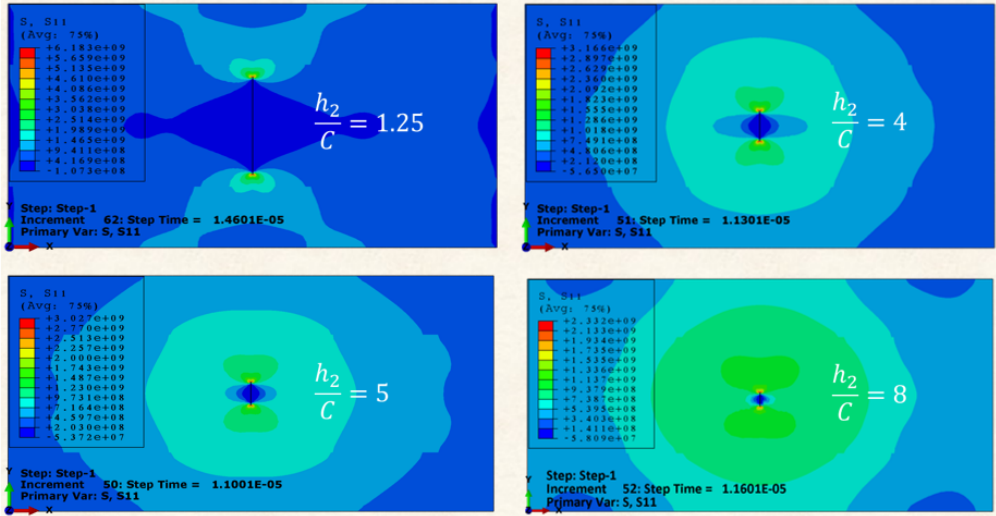
Figure 6. Crack length effect on stress distribution for PZT-5H composite.